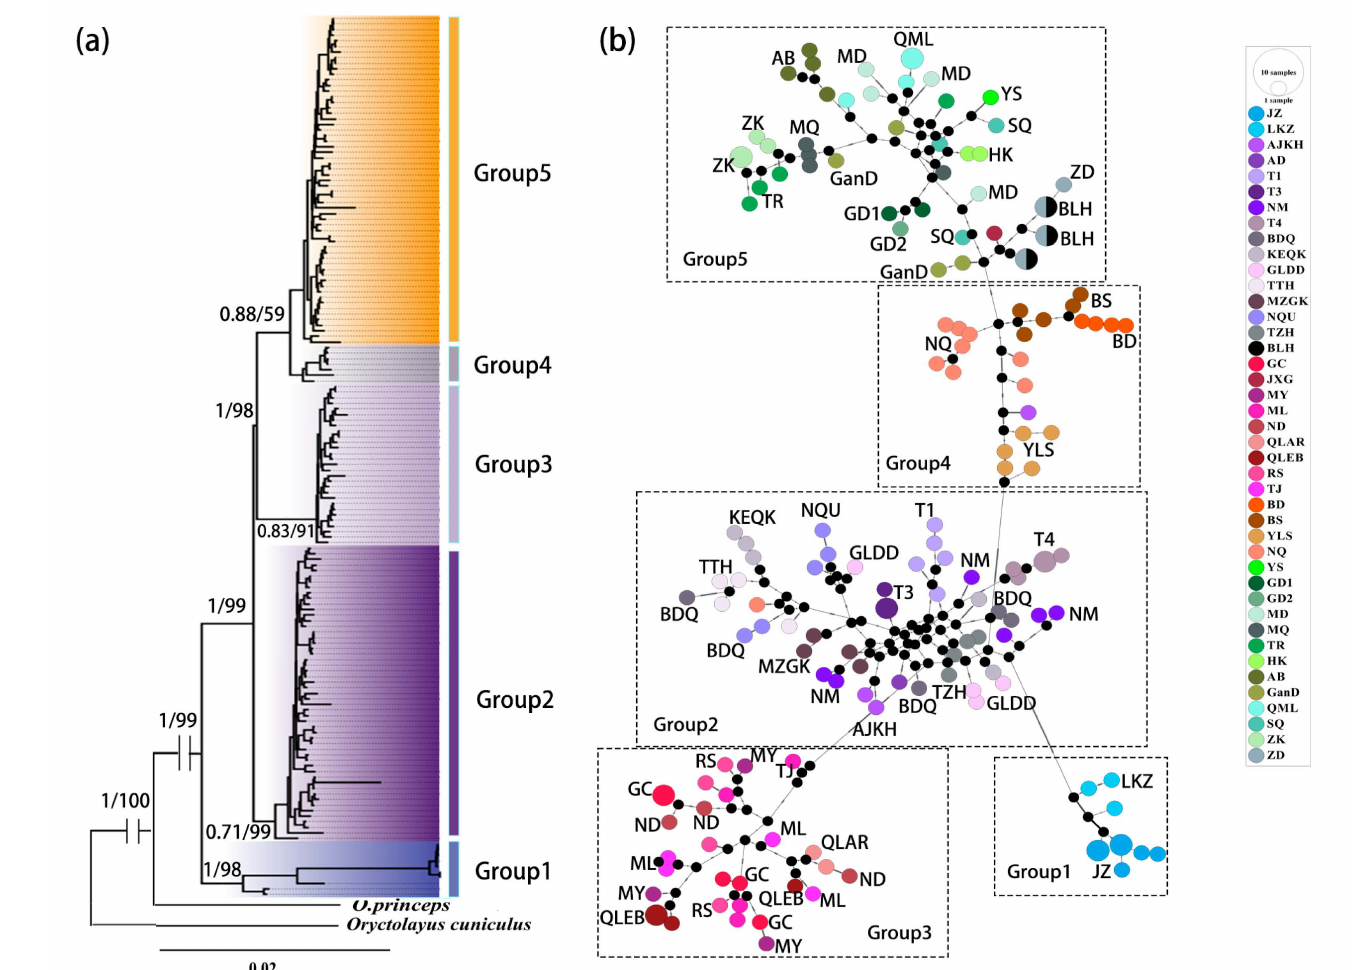
Figure 3. Maximum likelihood (ML) phylogenetic tree ( a ) and median-joining network ( b ) based on the combined dataset ( 12S rRNA + COI + D-loop + Cytb + GHR + IRBP + RAG1 ) of plateau pikas. Values near the node indicate the posterior probability values and bootstrap values of the phylogenetic tree. Short bars in the haplotype network represent mutation steps and the black dots represent missing haplotypes. The circle name and color correspond to different regions, and the haplotype circle size denotes the number of sampled